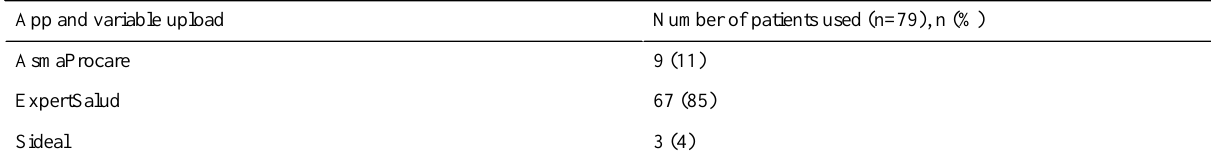
Table 4. Apps use by